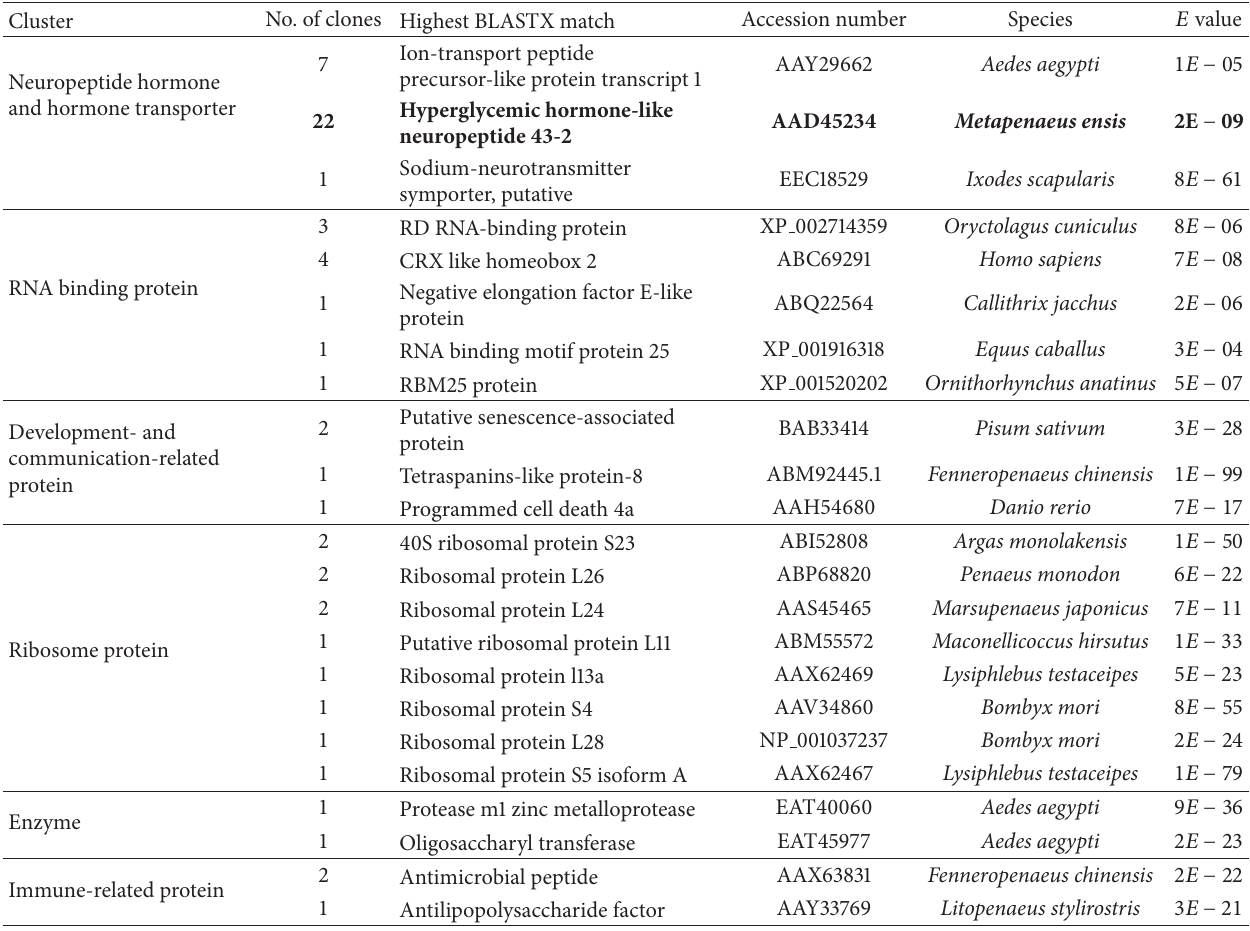
Table 2: Blast homology search results of genes isolated from the MRT-SSH library.